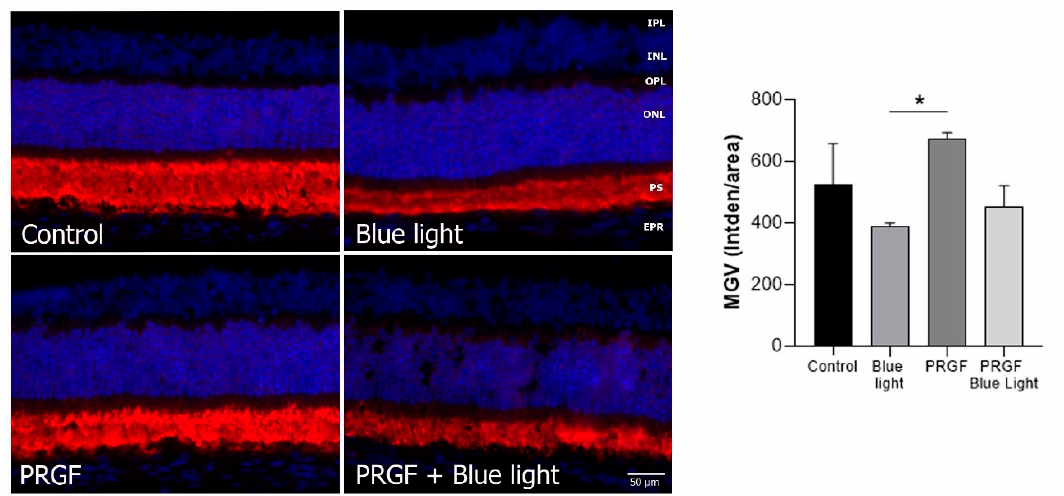
Figure 6. Immunofluorescence for rhodopsin (red) and DAPI (blue) in transversal section of retinas ( n = 4). The results showed that the expression of rhodopsin was reduced by blue light compared to PRGF treatment conditions. Statistical analysis: One-way ANOVA, Sidak’s multiple comparison test, * p < 0.05. Scale = 50 µm.